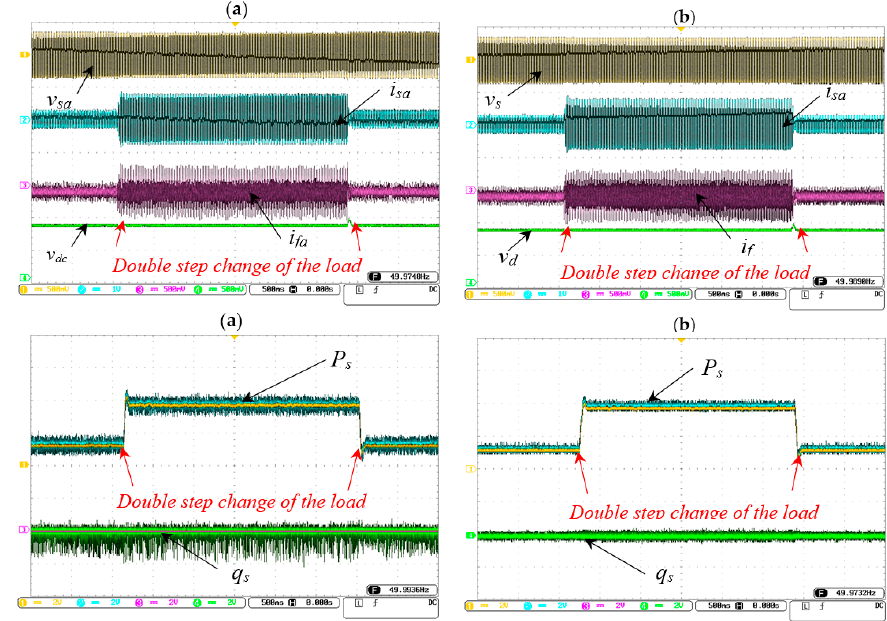
Figure 15. Main parameters of the system during load variation by using conventional DPC ( a ) and MPPC-SVM ( b ).